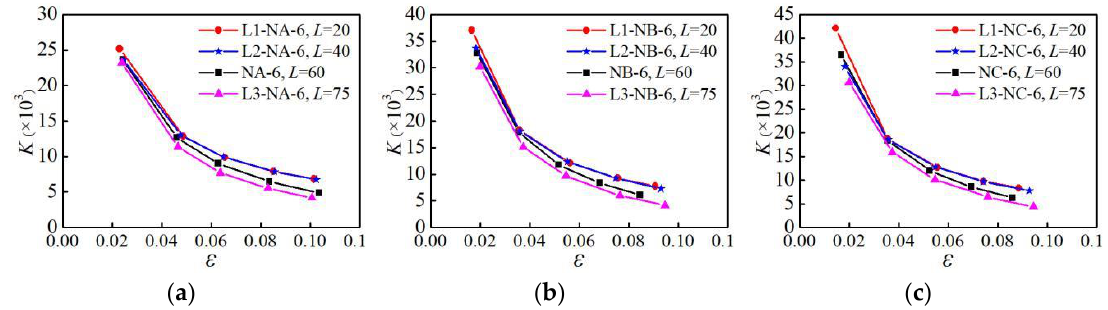
Figure 20. Influence of parallel section length on secant stiffness: ( a ) group A of specimens; ( b ) group B of specimens; ( c ) group C of specimens.